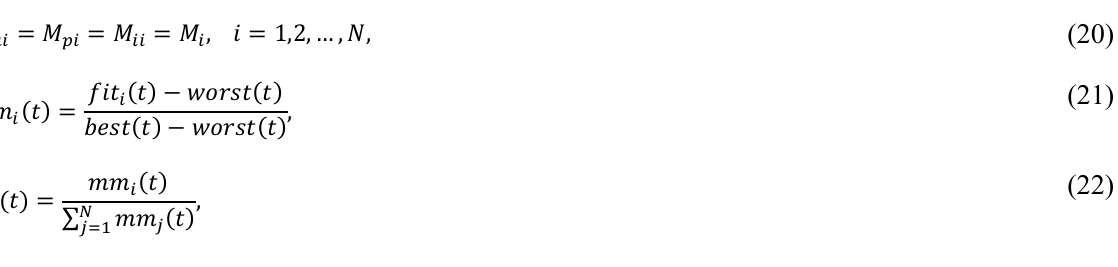
Table 5 New populations’ generation